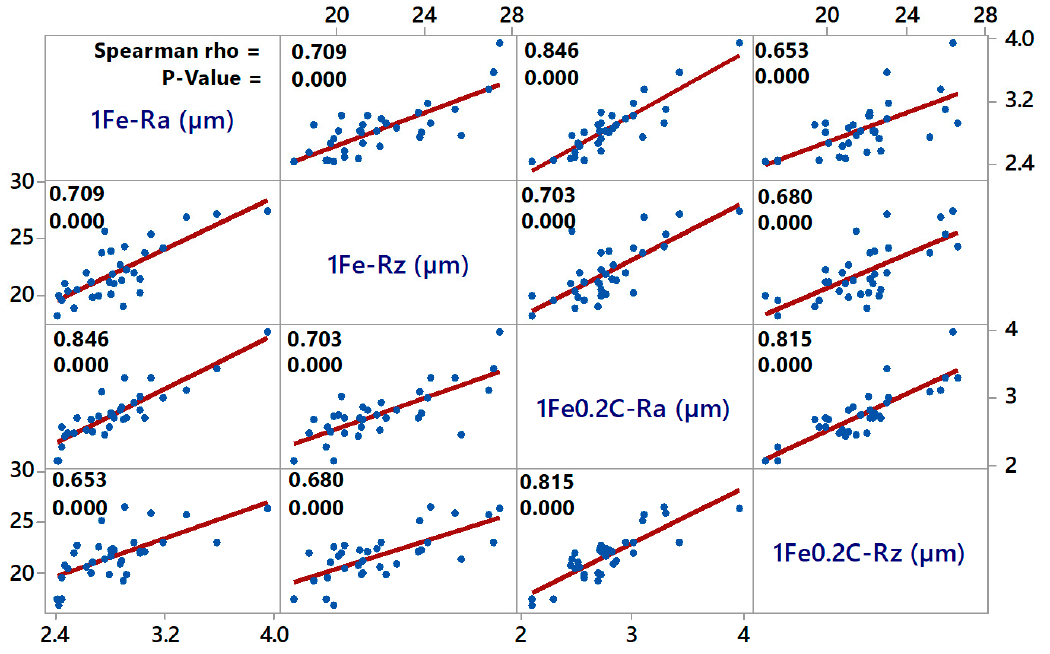
Figure 4. Matrix plot of surface topography parameters Ra and Rz.